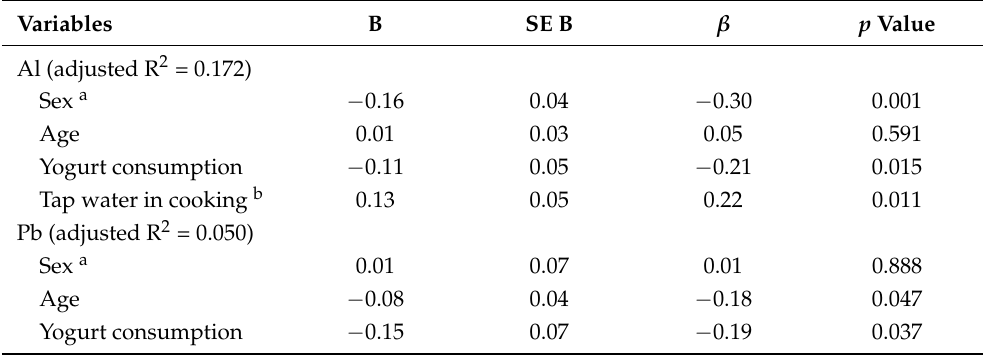
Table 6. Multiple regression analysis predicting the log-transformed hair Al and Pb concentrations in children’s hair.